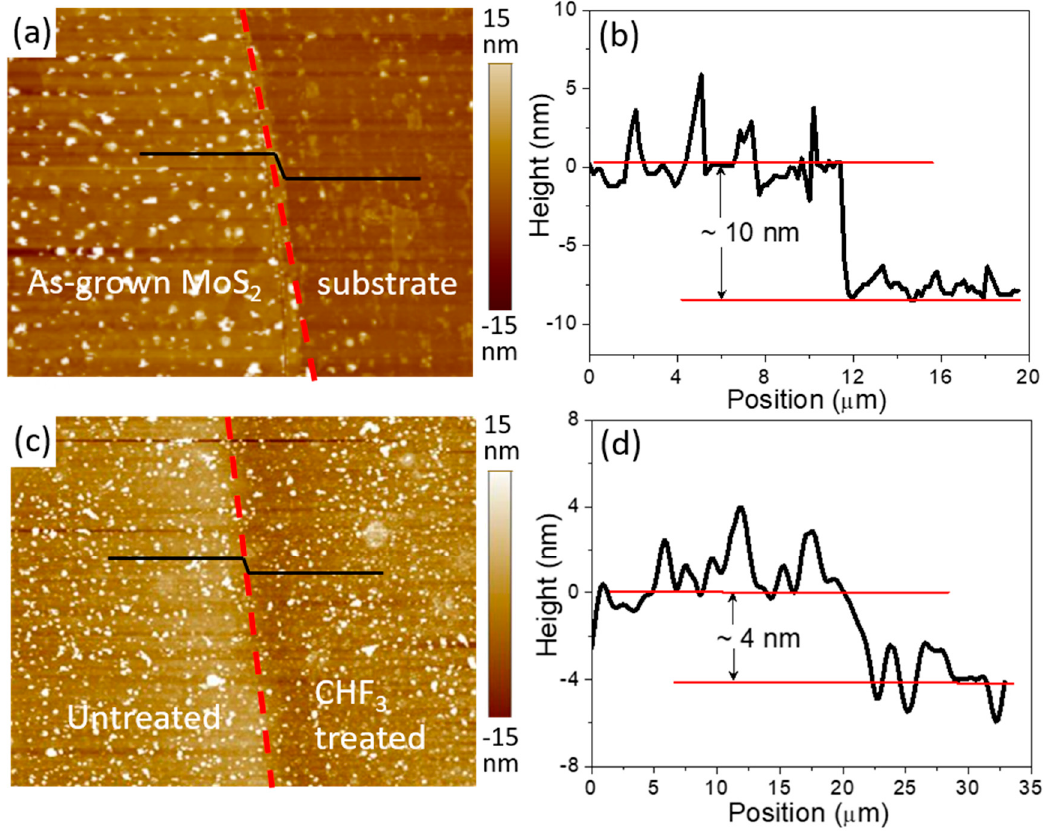
Figure 2. ( a ) Atomic force microscopy (AFM) height image of the as-grown MoS 2 films. ( b ) Line scan of the as-grown MoS 2 -substrate interface. ( c ) AFM height image and ( d ) line scan across the CHF 3 -treated and untreated interface of the MoS 2 film.